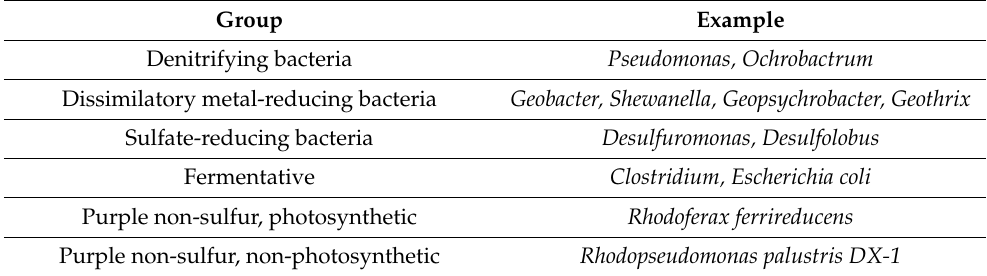
Table 2. Common groups of exo-electrogenic bacteria. Group Example Denitrifying bacteria Pseudomonas, Ochrobactrum Dissimilatory metal-reducing bacteria Sulfate-reducing